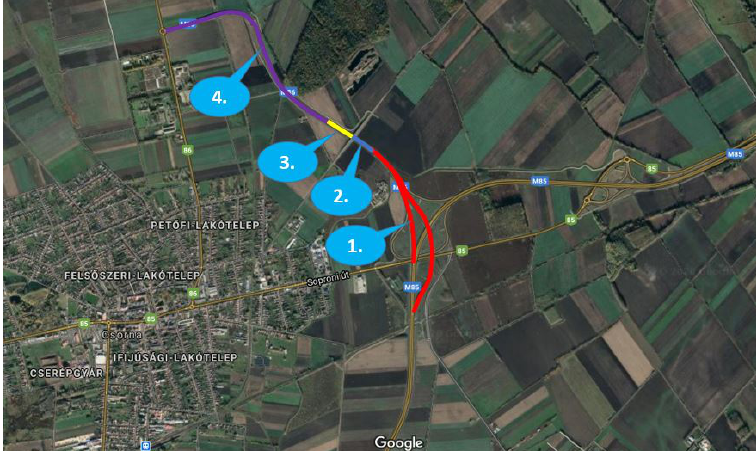
Figure 5. Sections of the test site created by closing a 3.5 km long segment of M86 Motorway from public